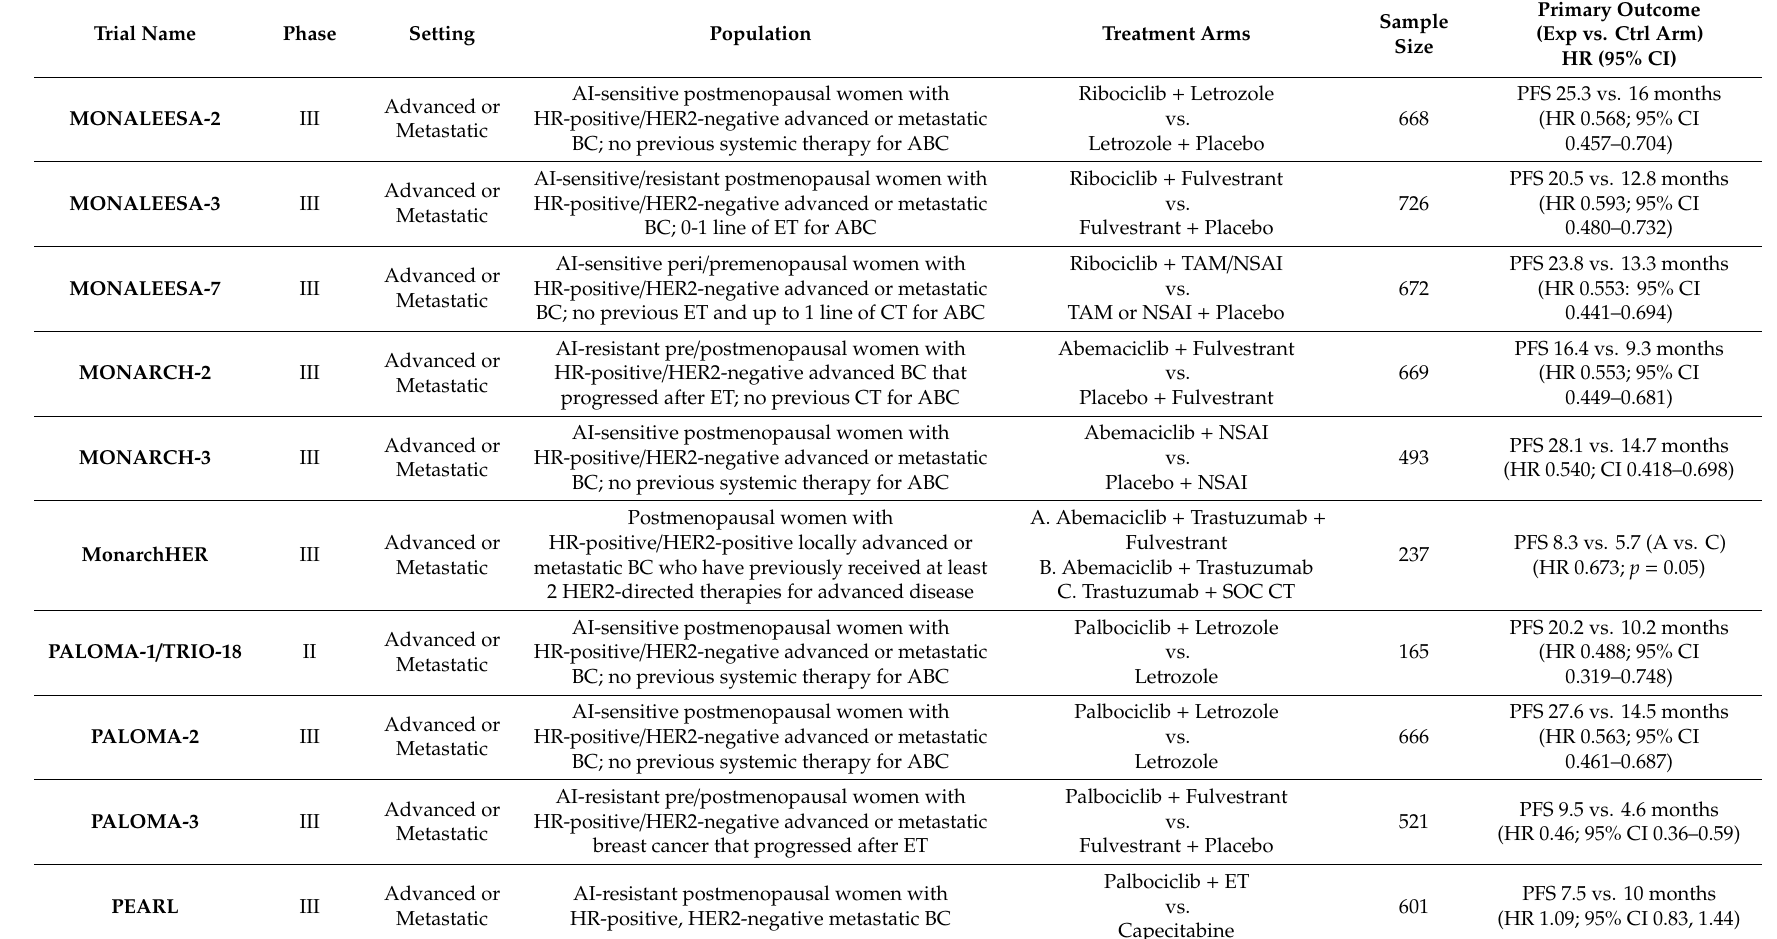
Table 1. Summary of randomized, phase II / III, clinical trials evaluating CDK4 / 6 inhibitors in